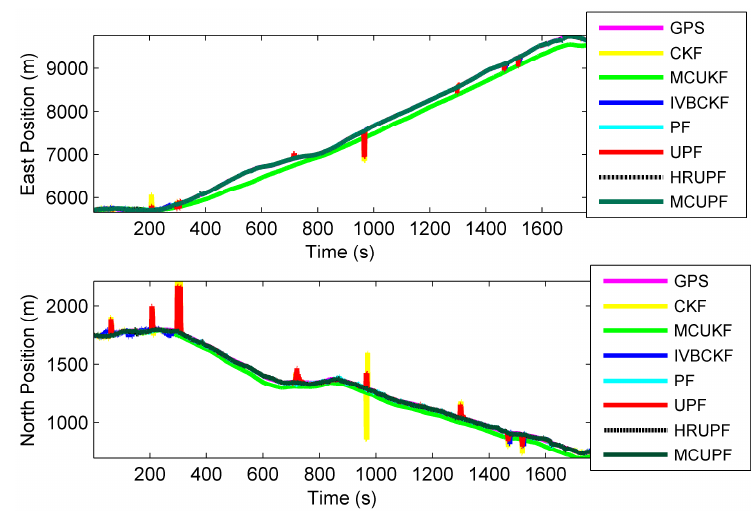
Figure 7. Paths taken by the proposed filter and existing filters.